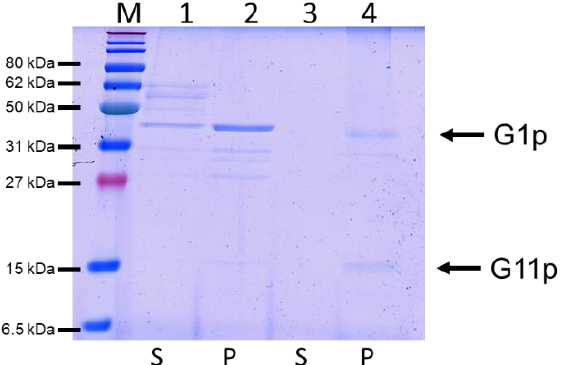
Figure 5. Reconstitution of HisG1p/G11p (lanes 1, 2) and G1p/G11pHis (lanes 3, 4) into PC liposomes to generate proteoliposomes. After sedimentation of the proteoliposomes, G1p and G11p were mainly found in the pellet (P) fraction and not in the supernatant (S).